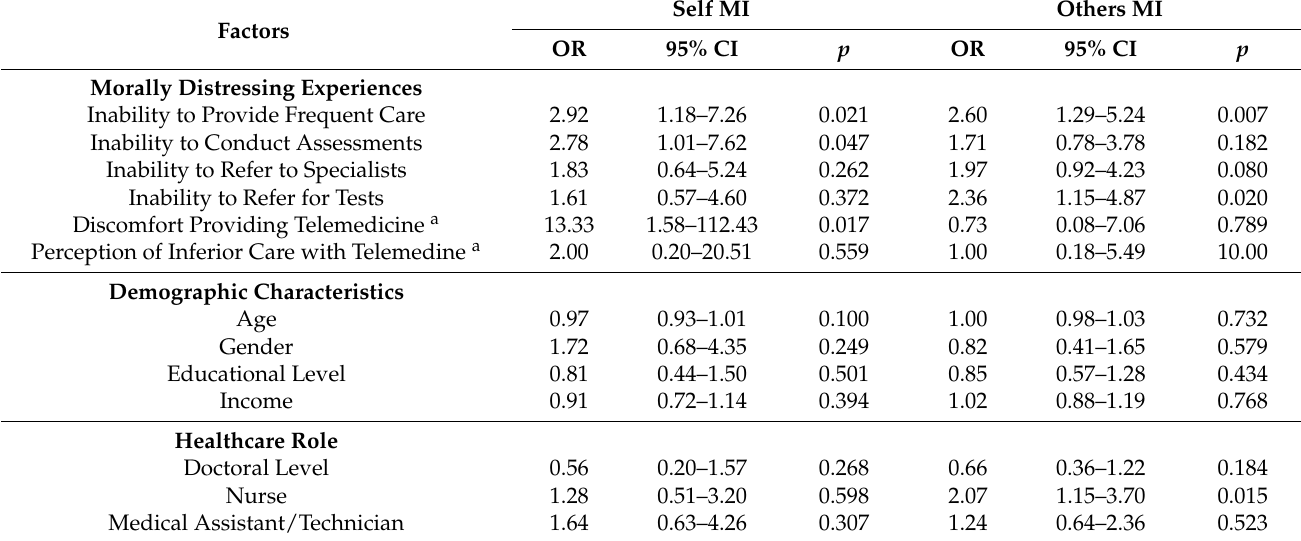
Table 3. Results of binary logistic regression odds of experiencing self and others moral injury.